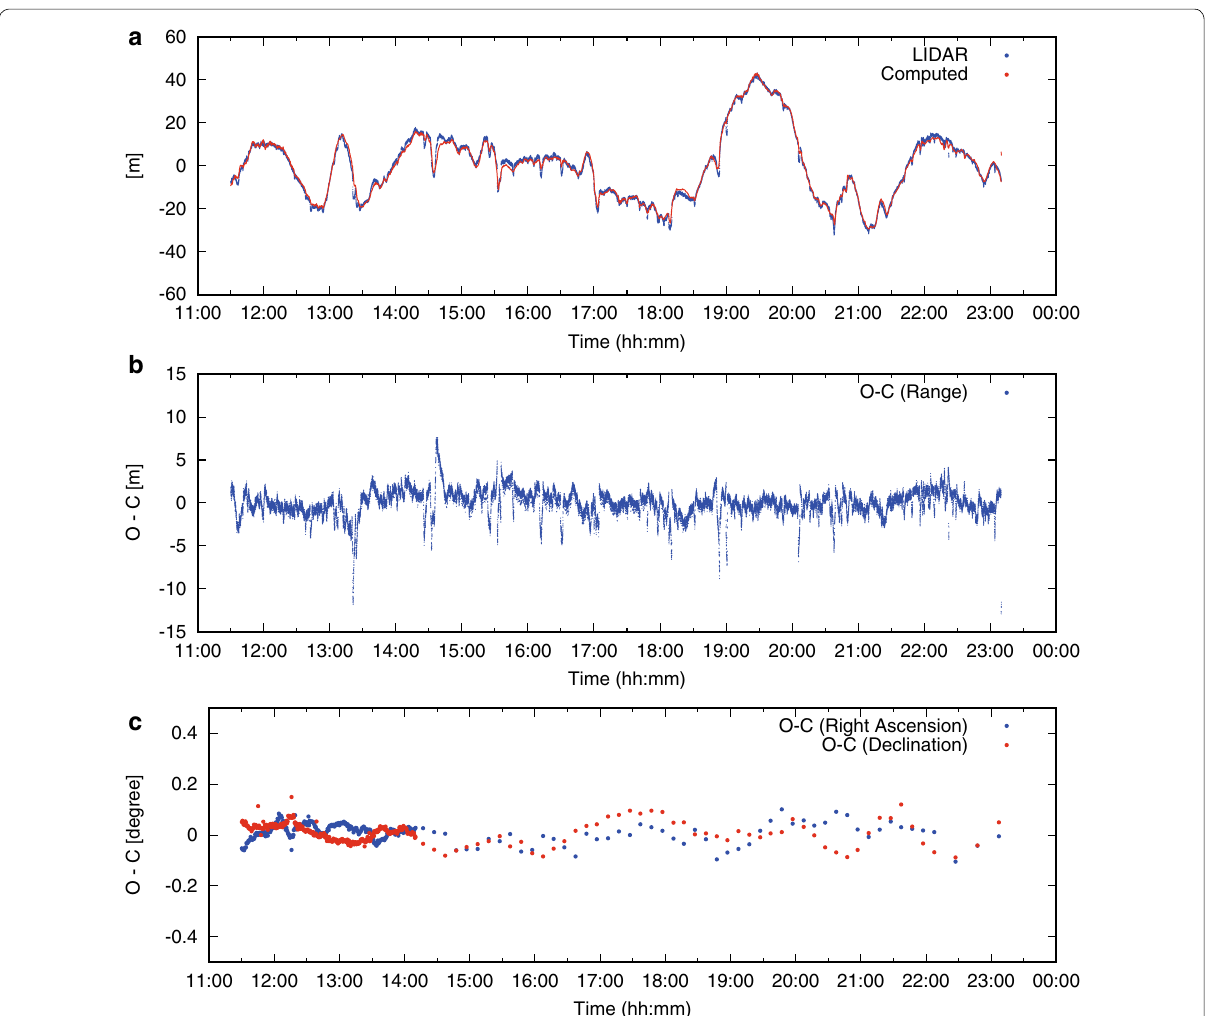
Fig. 6 a Residuals of LIDAR range of arc No. 3 in Table 1 (blue) and the corresponding computed range (red) after removing long‑wavelength components via quadratic equation fitting. b The difference between the observed and computed ranges for arc No. 3. c The difference between observed and computed right ascension (blue) and declination (red) angles of the centroid directions viewed from the Hayabusa2 spacecraft for arc No.